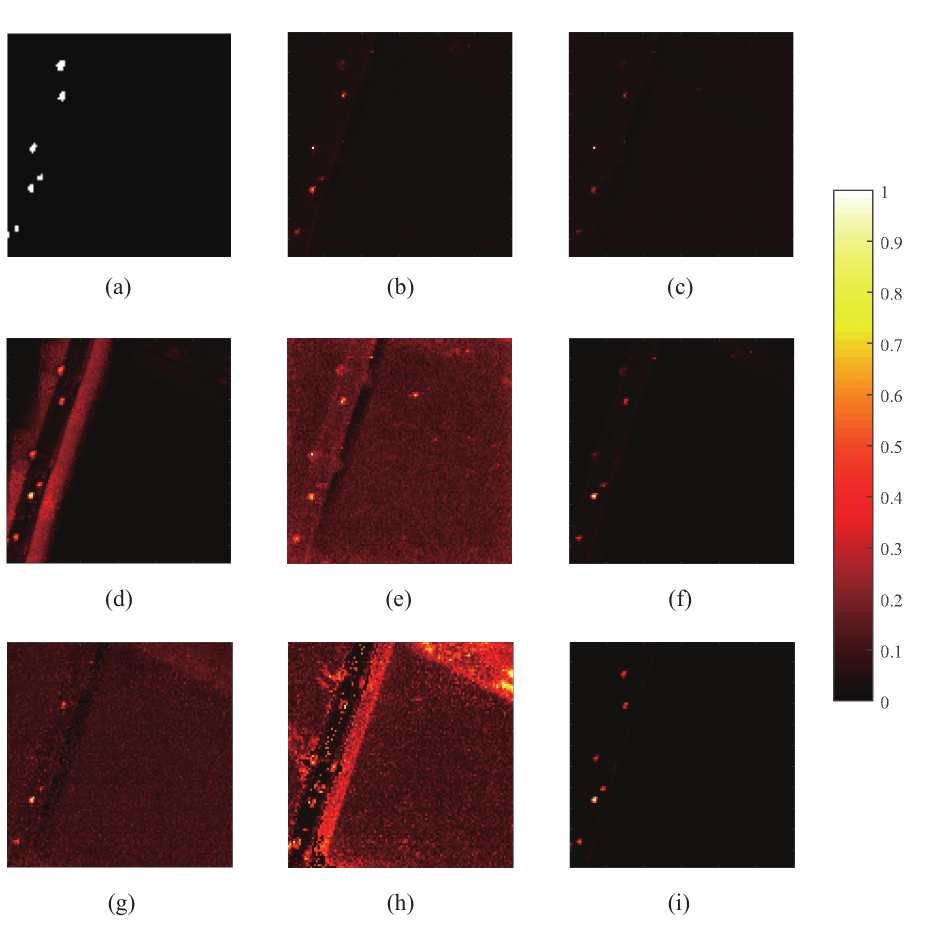
Figure 7. The detection maps of different algorithms for the Pavia center dataset, the parameters in brackets are sizes of double-window used in corresponding algorithms. ( a ) Reference map. ( b ) GRX. ( c ) LRX (5,29). ( d ) BJSR (3,23). ( e ) CRD (3,23). ( f ) LSMAD. ( g ) LRASR. ( h ) KIFD. ( i ) LCLRR.